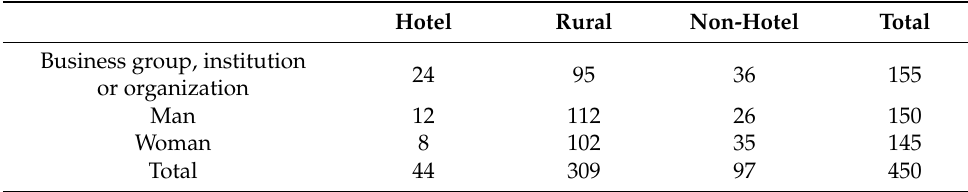
Table 1. Establishment owner and types of accommodations.